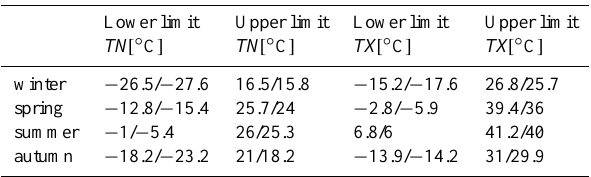
ders/Ardenne zones per seasons used in the physical limit consis- tency